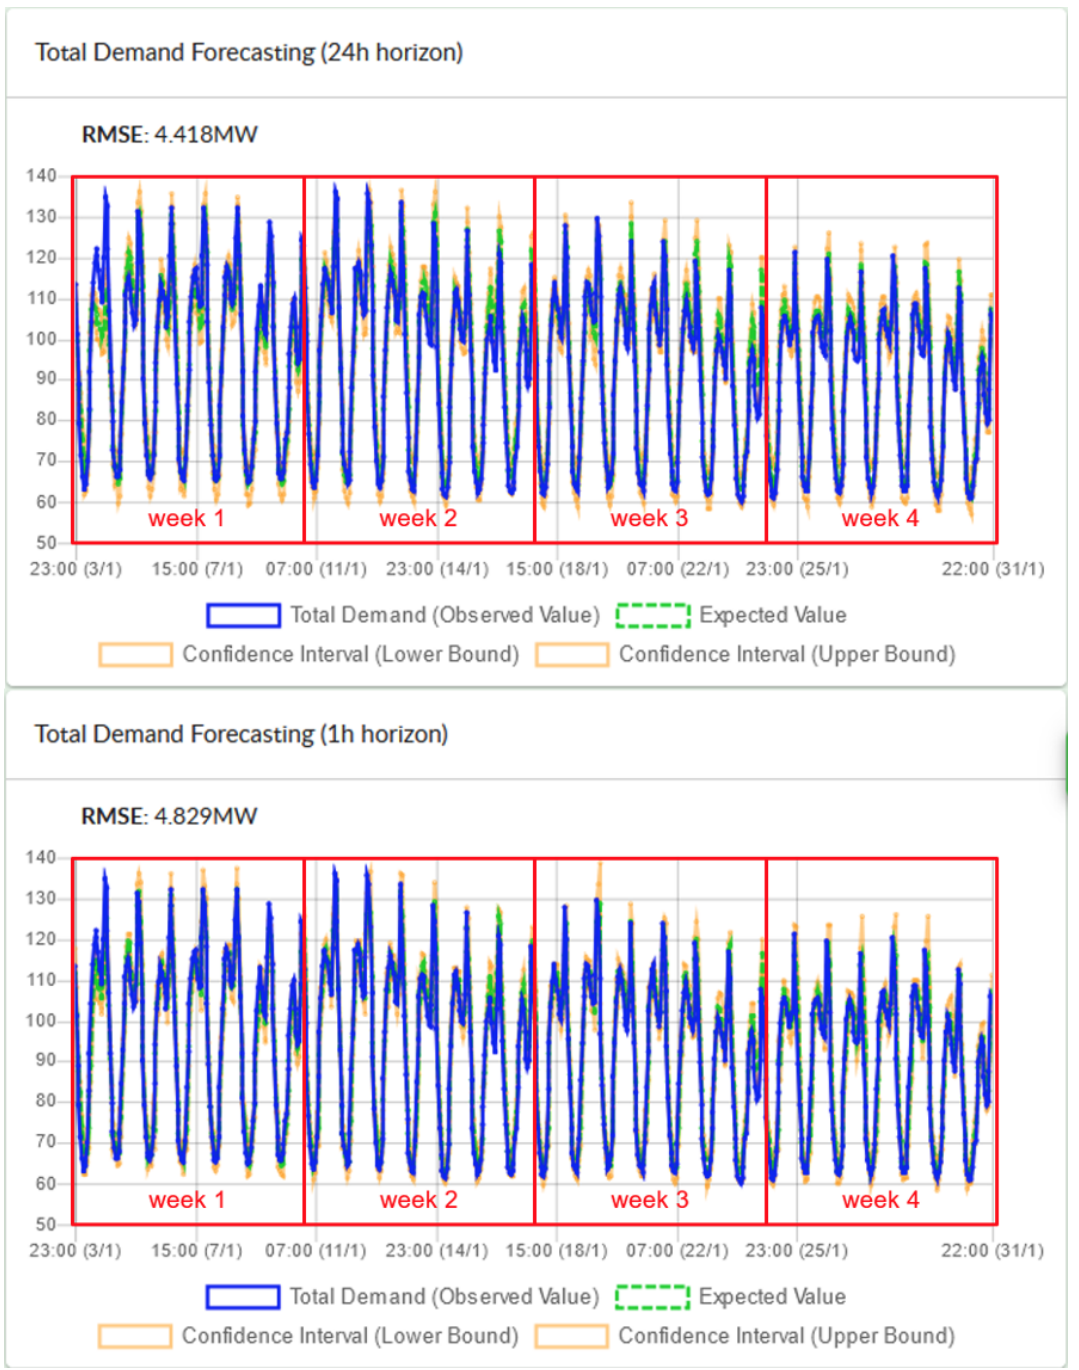
Figure 6. Time series of exact and forecast values with 95% confidence interval for Madeira demand during the first 4 calendar weeks of 2021, based on 24-h ( top ) and 1-h ( bottom ) forecasting horizon. The effect of average time profile and the day of week clusters (business days, Saturday, Sunday) on all values is shown. The measurement unit of demand is MW and the time zone is 2 h ahead of